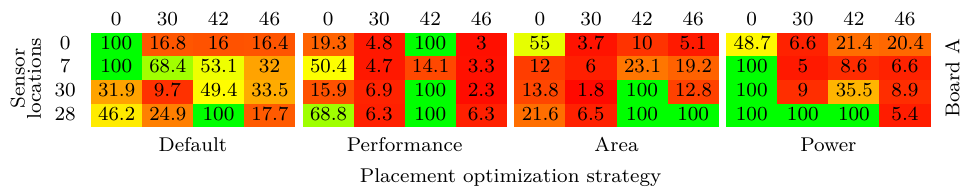
Figure 15: Minimum amount of traces ( × 1 , 000) required to attack the second round key byte on board A. Red colored cells correspond to combinations where an attack is easy, green colored to parameters resulting in a difficult attack. A value of 100 k means that we were unable to recover the key with 100 k